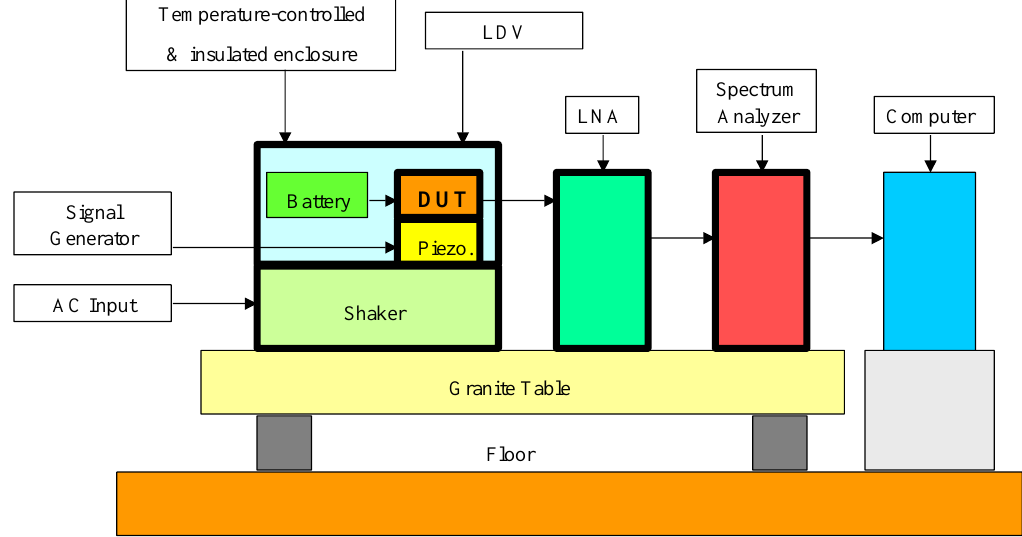
Figure 3. Schematic of the noise measurement setup. A granite table being suspended on air bearings will isolate the setup from external vibrations. The device under test (DUT) could be in open-die or package. A static measurement could be made by tilting the DUT with reference to gravity. The dynamic measurements could be made with the piezoelectric disc or shaker, each of, which has its own drivers, indicated to the left. In the electrical-based setup, the output signal from DUT is fed to a low noise amplifier (LNA) to provide signal gain. Then, the amplified signal is sent to a spectrum analyzer to display the noise characteristics. In the optical setup, the laser Doppler vibrometer (LDV) is used to optically assess the motion of the microsensor on the open die. The data from both the spectrum analyzer and LDV will be stored in a computer. The separation of electrical- and mechanical-based noise sources is performed by signal processing software when the purely mechanical noise spectra from LDV measurement are deducted from the combined noise spectra of the spectrum analyzer. It should be noted that several components are not illustrated in Figure 3, including a speaker to introduce acoustic excitation and the means for heating or cooling the DUT.